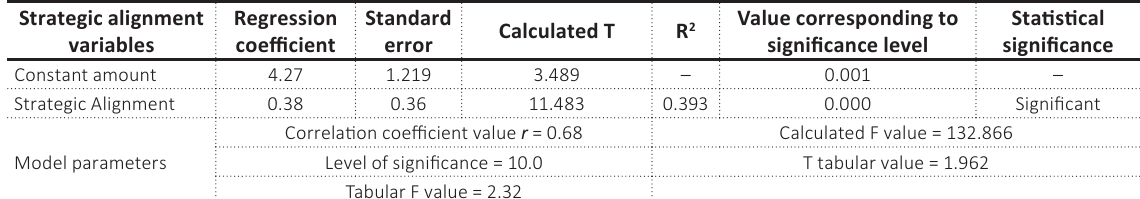
Table 6. Results of a simple linear regression analysis, impact of strategic alignment on